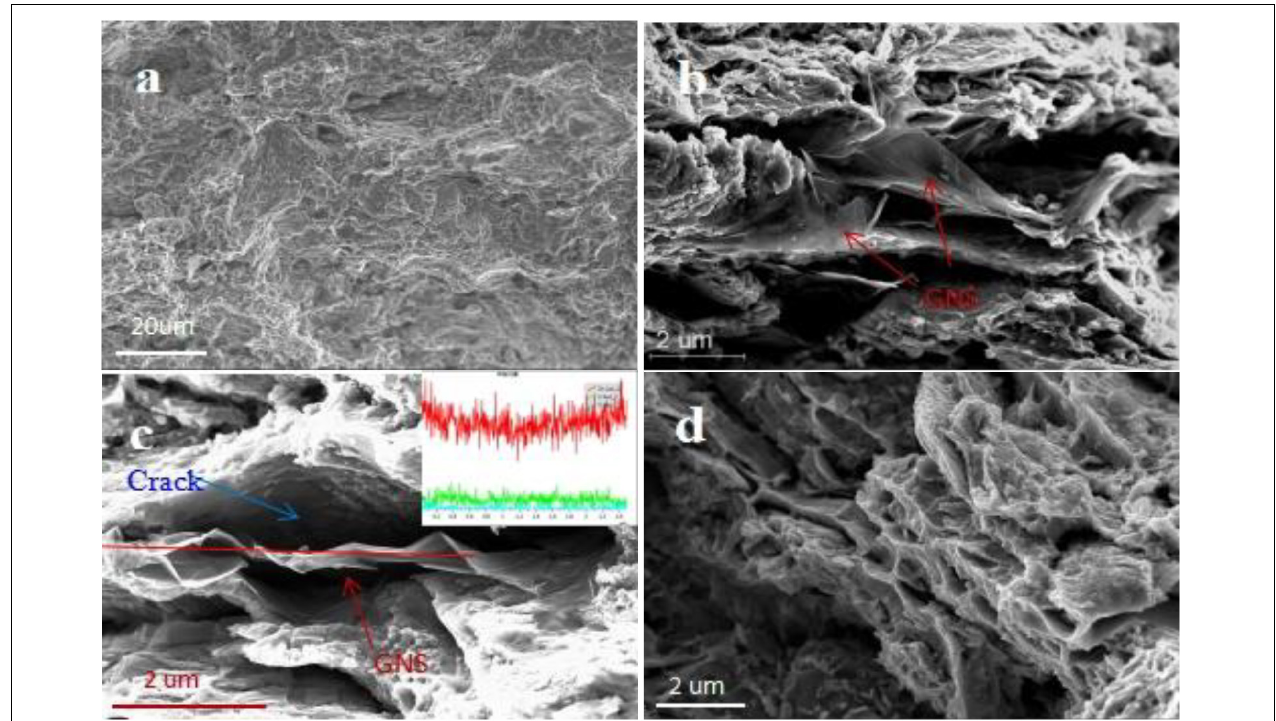
FIGURE 7 | (A) the morphology of the tensile fracture of the GNS/Zn composite at low magnification, (B,C) morphological distribution of reinforcement at the fracture (the inset is a line scan of GNS), (D) elongated dimples morphology at the fracture of GNS/Zn